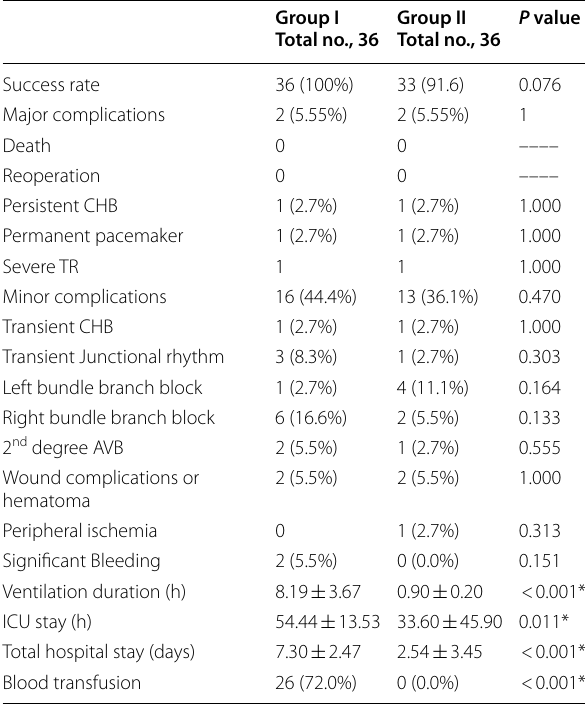
Table 5 Comparison of Postoperative data between groups I and